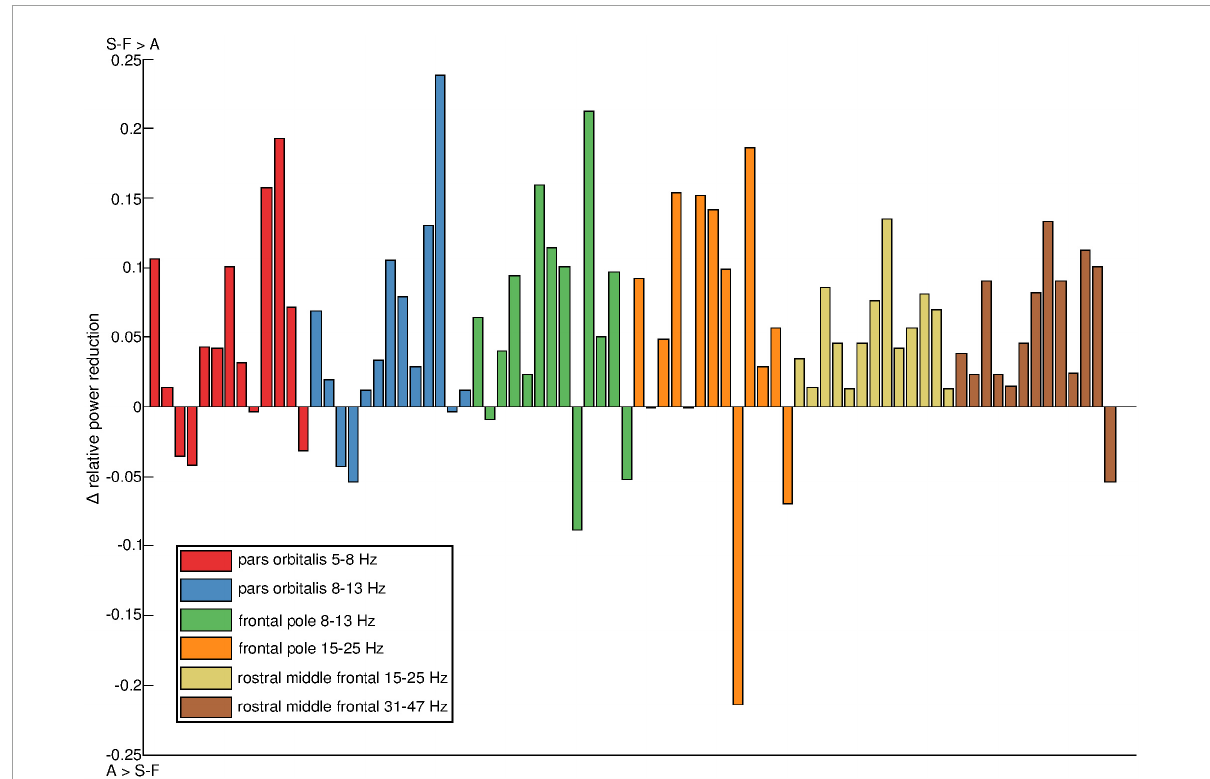
FIGURE5 Individual variation of power reduction by SOBI-FastICA vs. AMICA in the six parcel and frequency band combinations for which the group-level difference between the methods exceeded 0.05. All such parcels were found in the right hemisphere. The results have been normalized by dividing them with the amount of power reduced by AMICA. Positive sign indicates that SOBI-FastICA reduced more power and negative sign that AMICA did. The colors denote the different parcel–frequency combinations. The colors were created with the linspacer function written by Lansey (2021) which uses colors derived mainly from ColorBrewer 2.0 (Brewer,